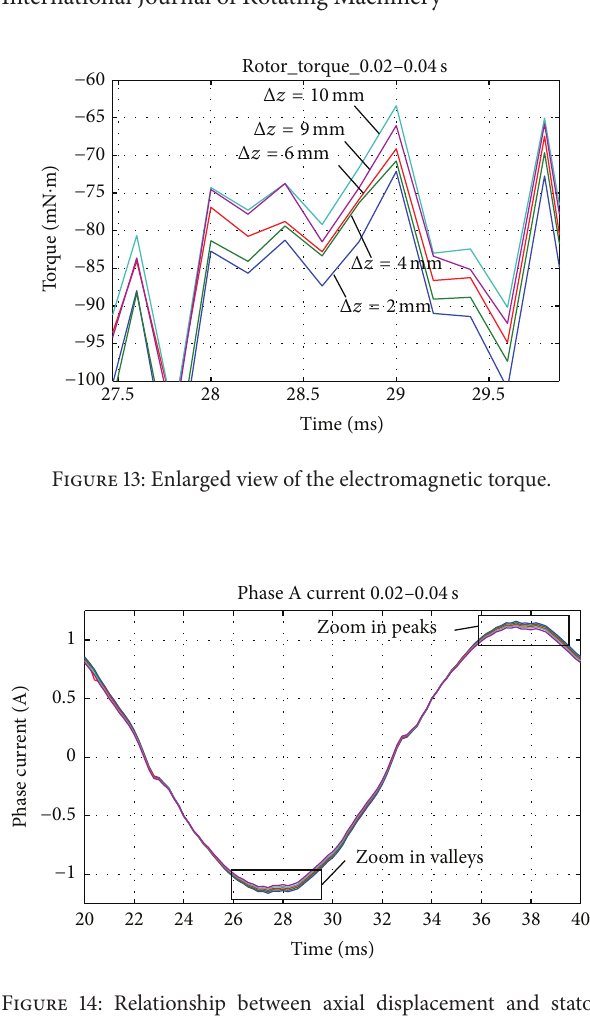
Figure 17: Magnetic density cloud map of SDF-9 type generator.